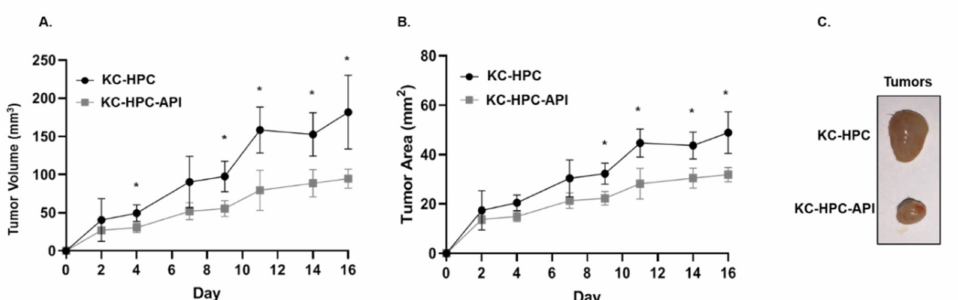
Figure 8. API treatment of KC-HPC mice decreased tumor burden. Tumor growth curves representing ( A ) tumor volume and ( B ) tumor area in KC-HPC mice treated with API. ( C ) Representative images of KC-HPC and KC-HPC-API tumors at the humane endpoint of the study. Data are presented as the mean ± S.D. of KC-HPC ( n = 3–4) and KC-HPC-API ( n = 3–4) mice. * p < 0.05 (by two-tailed t